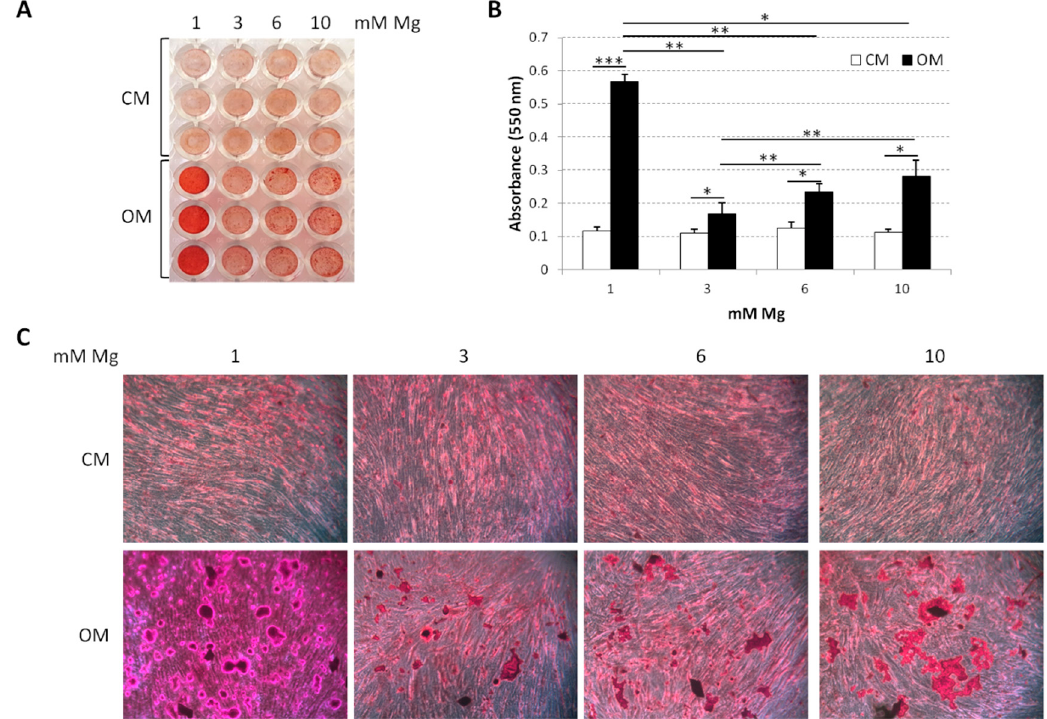
Figure 5. Effects of supra-physiological Mg concentrations on VD3-induced osteoblastic differentiation. Alizarin Red staining was performed on bone-marrow-derived mesenchymal stem cells (bMSCs) cultured in 1, 3, 6, and 10 mM Mg added (OM) or not (CM) with the osteogenic cocktail for 14 days. Whole-well image ( A ) and photographs taken at 10× magnification ( C ) are shown. Absorbance was measured at 550 nm after acid extraction ( B ). * p < 0.05, ** p < 0.01, *** p < 0.001.